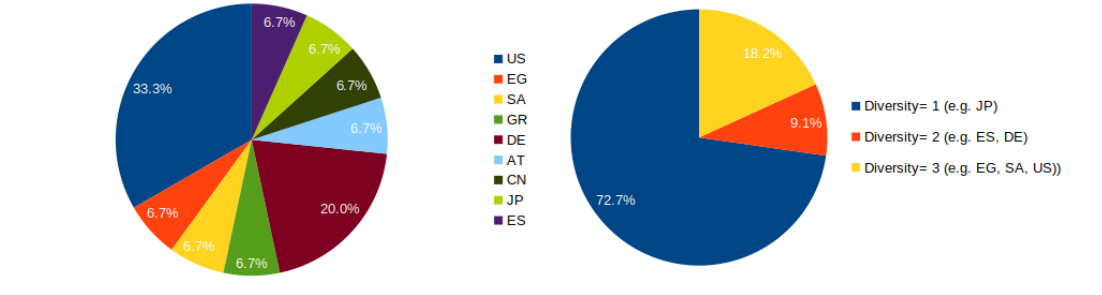
Figure 7. Diversity of areas of studies within the same